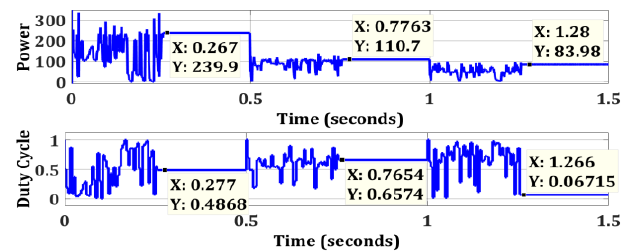
Fig. 13. Performance of MFPA under continuous changing